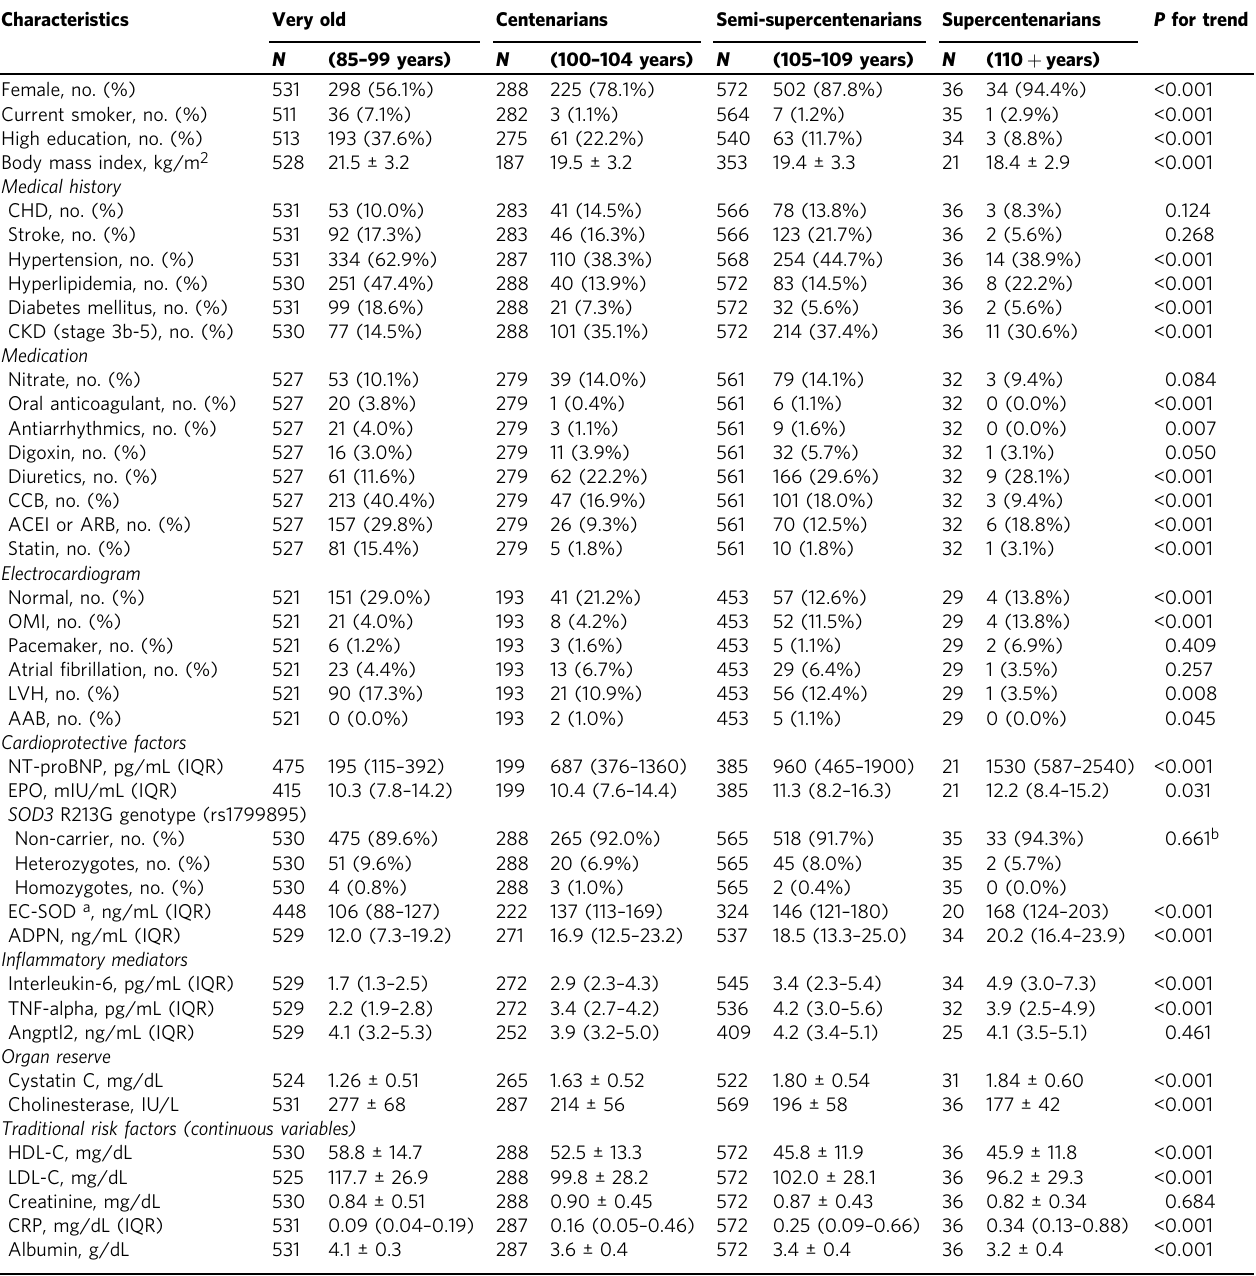
Table 1 Selected characteristics of participants according to age at